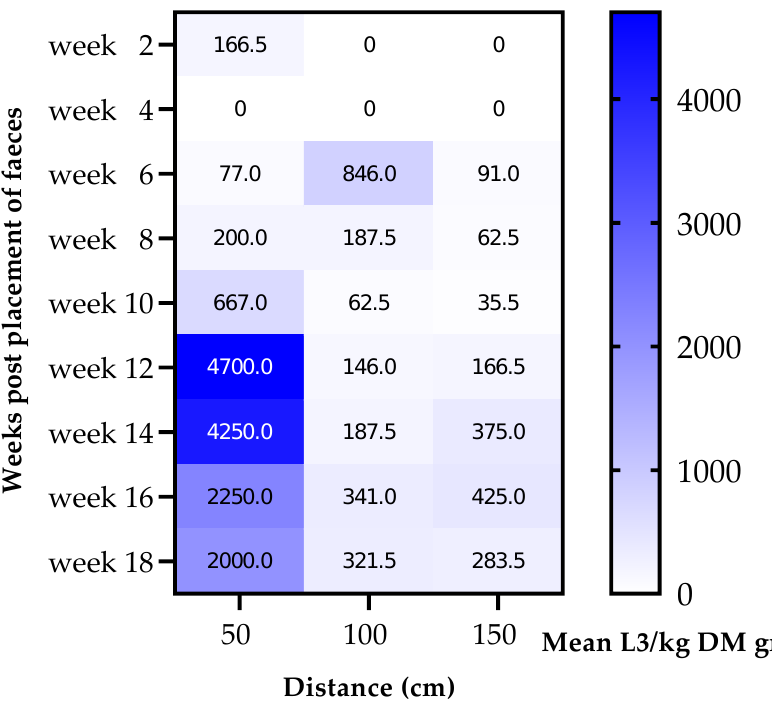
Figure 8. Heat map showing larval yield (mean L3/kg DM grass) at each distance zone from the faecal pats (50, 100 and 150 cm) during each sampling week of the migration study.